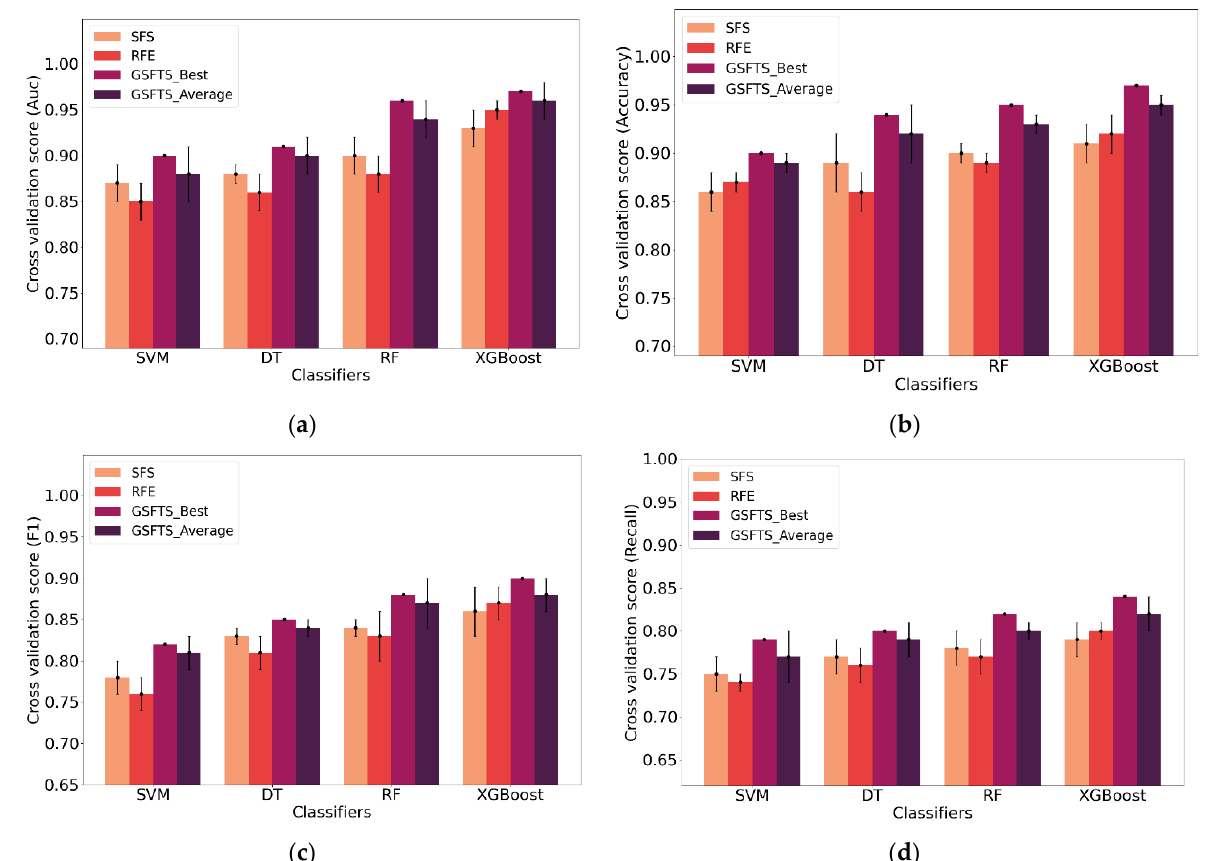
Figure 16. Performance comparison of the four prediction models under the three sets of feature combination: ( a ) AUC; ( b ) accuracy; ( c ) F1; ( d ) recall.